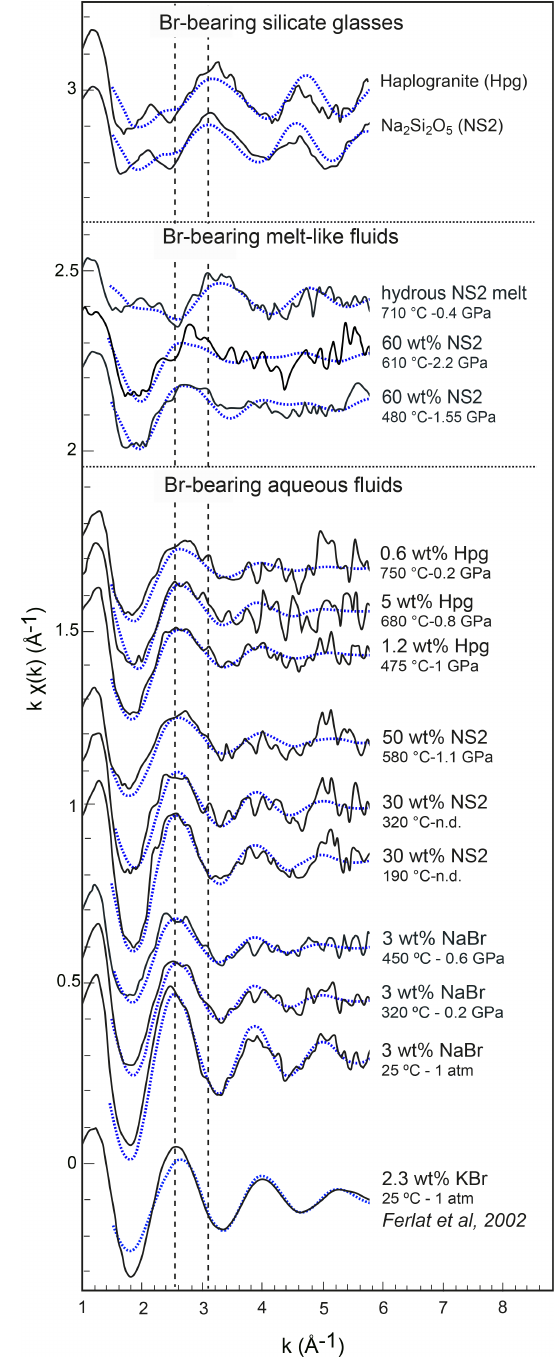
Figure 5. Normalized k 1 -weighted EXAFS oscillations of the in- vestigated Br-bearing samples (black solid lines) and corresponding least-square fits (blue dashed lines). Spectra are offset vertically for clarity. The pressure and temperature conditions and the composi- tions are reported to the right of each spectrum. The dashed lines underline the shift of EXAFS oscillations with a change in compo-